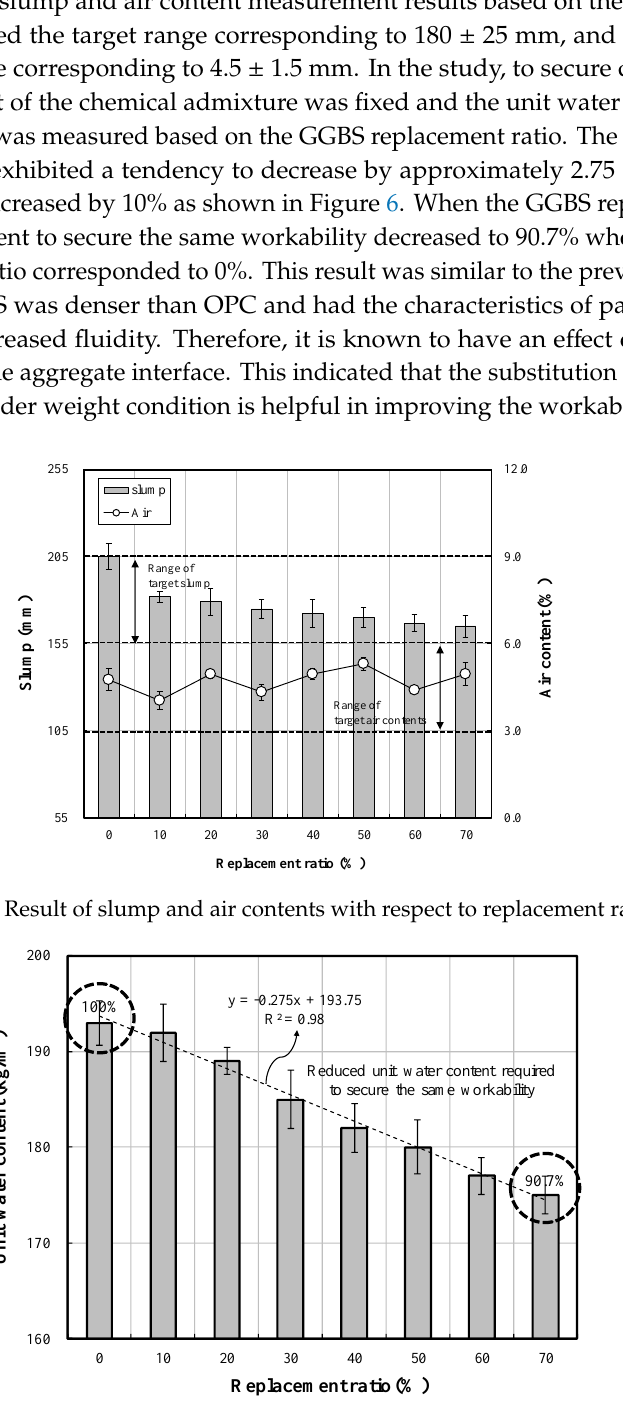
Figure 4. X-ray diffraction patterns of OPC and GGBS.